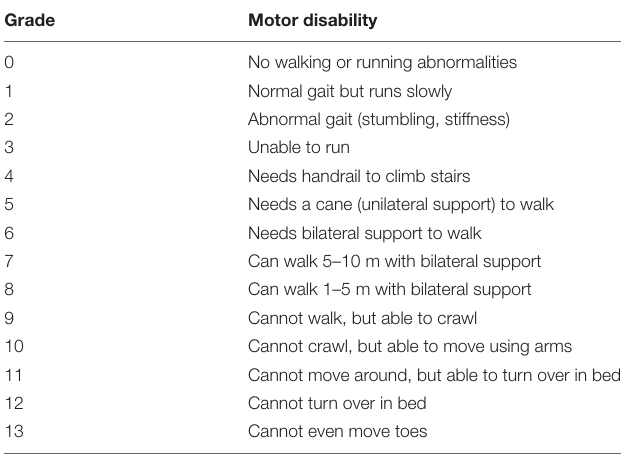
TABLE 1 | Osame motor disability